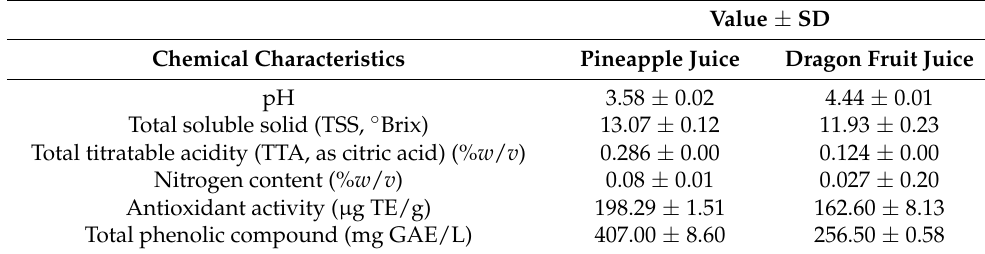
Table 1. Basic chemical characteristics of fresh juices.